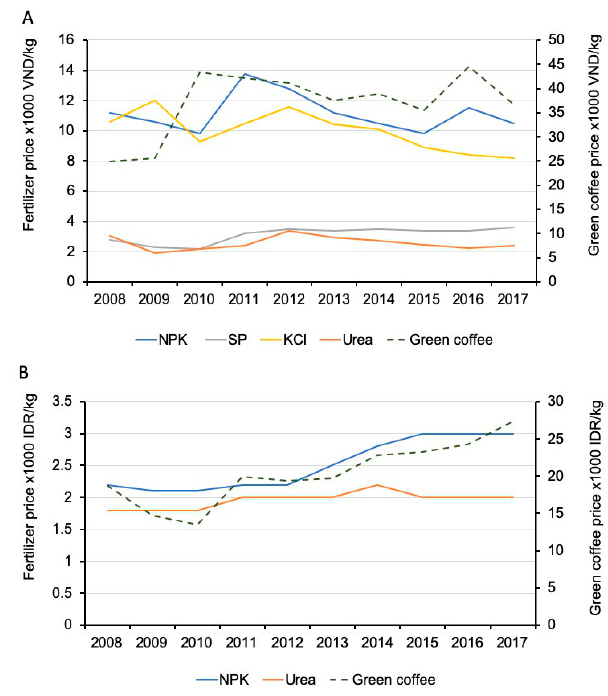
Figure 4. Average prices of the top three fertilizers and green Robusta coffee in Vietnam ( A ) and Indonesia ( B ) during the 2008–2017 period. Coffee prices were sourced from the International Coffee Organization (http://www.ico.org/new_historical.asp). VND: Vietnam Dong. IRD: Indonesia Rupiah. NPK: blended NPK; SP: super phosphate; KCl: potassium chloride.